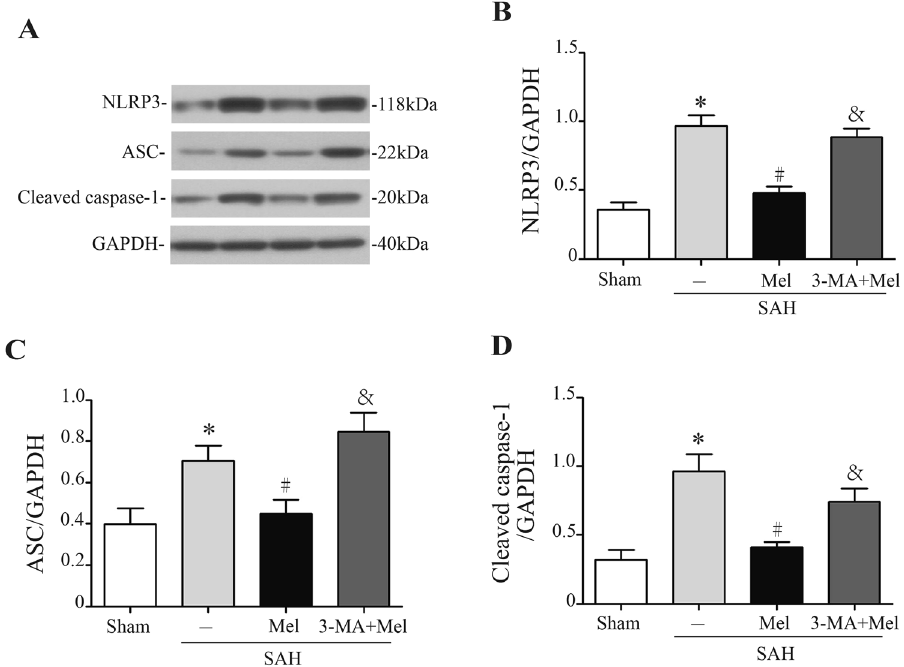
Figure 4. Melatonin treatment inhibits NLRP3 inflammasome activation. ( A ) Representative Western blot bands of NLRP3, ASC, and cleaved caspase-1. ( B – D ) The relative band densities of NLRP3, ASC, and cleaved caspase-1; n = 6 per group. The cropped bands had been run under the same experimental conditions. * P < 0.05 versus sham group, # P < 0.05 versus SAH + vehicle group, and & P < 0.05 versus SAH + Mel